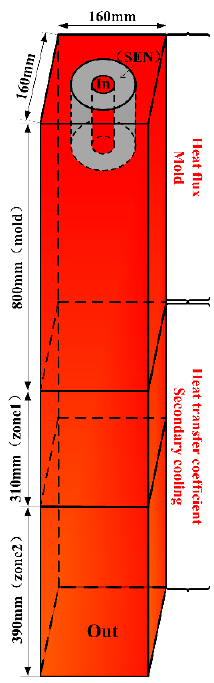
Figure 1. Schematic diagram of the calculation domain and boundary condition.